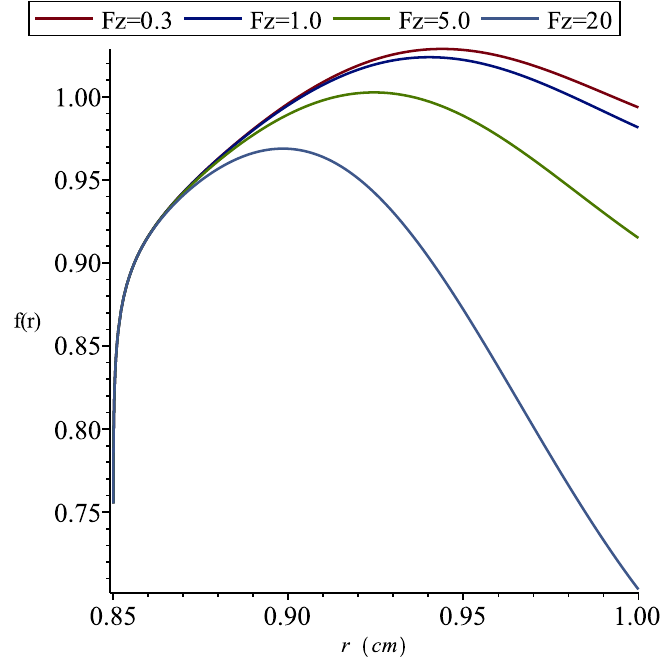
Figure 2. f versus r for α = − 1000 in level set function φ , R i = 0.85 cm is the radial value at the gas/liquid